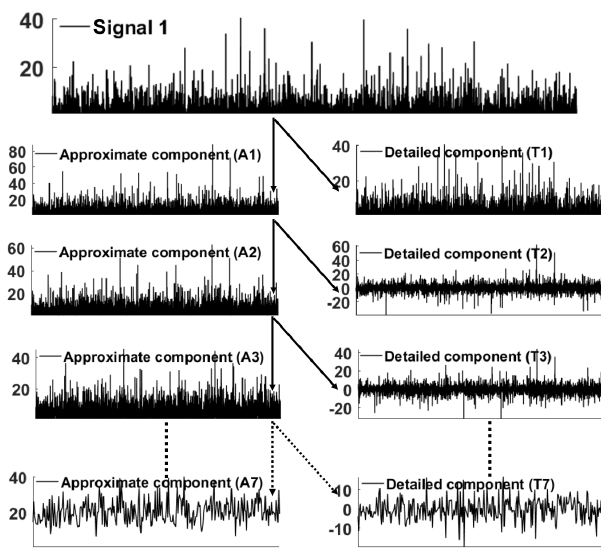
Figure 2. Scheme of multi-scale decomposition of signals using discrete wavelet transformation (DWT). The relationship between signal, approximate component, and detailed component is